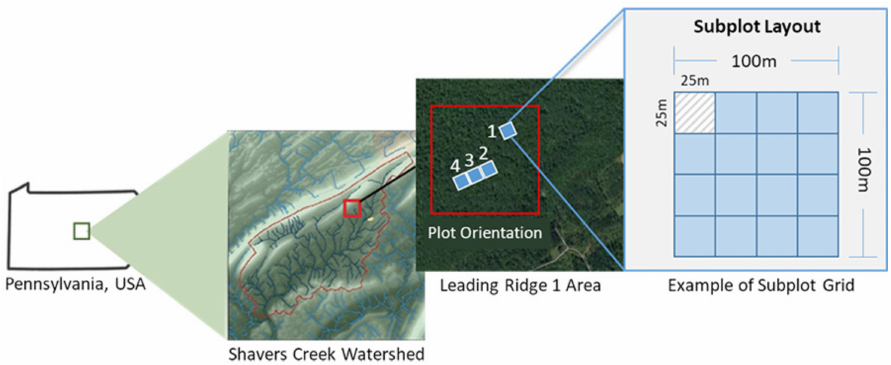
Figure 1. Relative locations of the study sites and layout of study